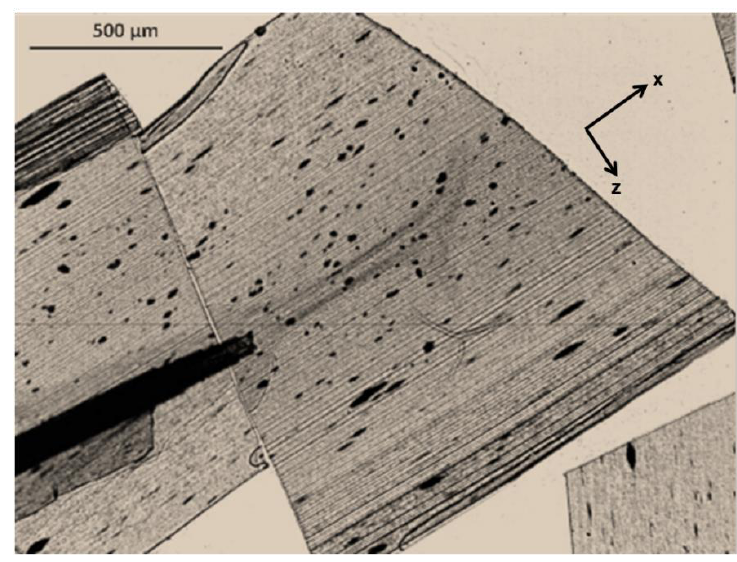
Figure 3. Optical micrograph of 3%-MWCNT nanocomposite, obtained from the entire thickness of the xz plane of the sample.